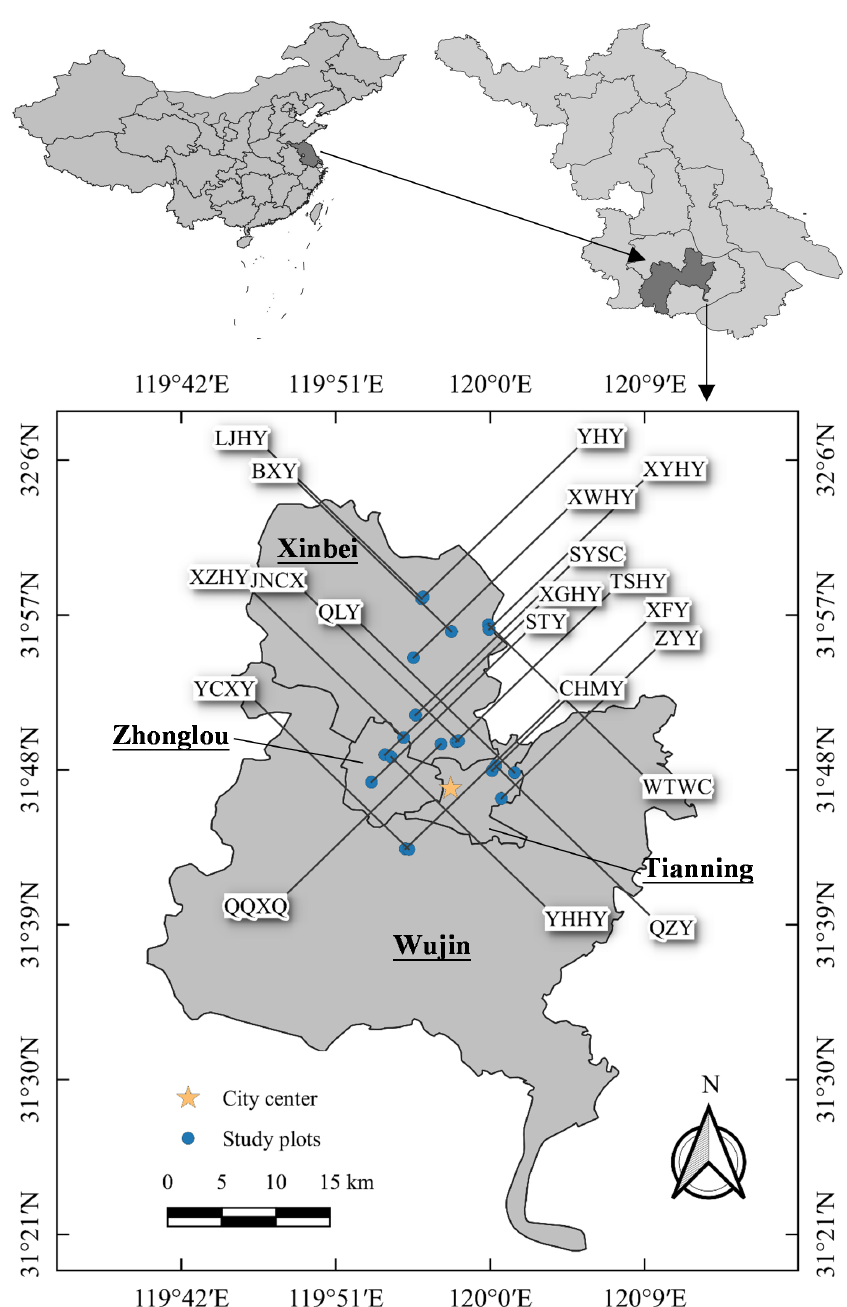
Figure 2. Locations of the 20 sampled resettlement residential areas (RRAs) of Changzhou. Refer to Table 1 for the full names of the RRAs.